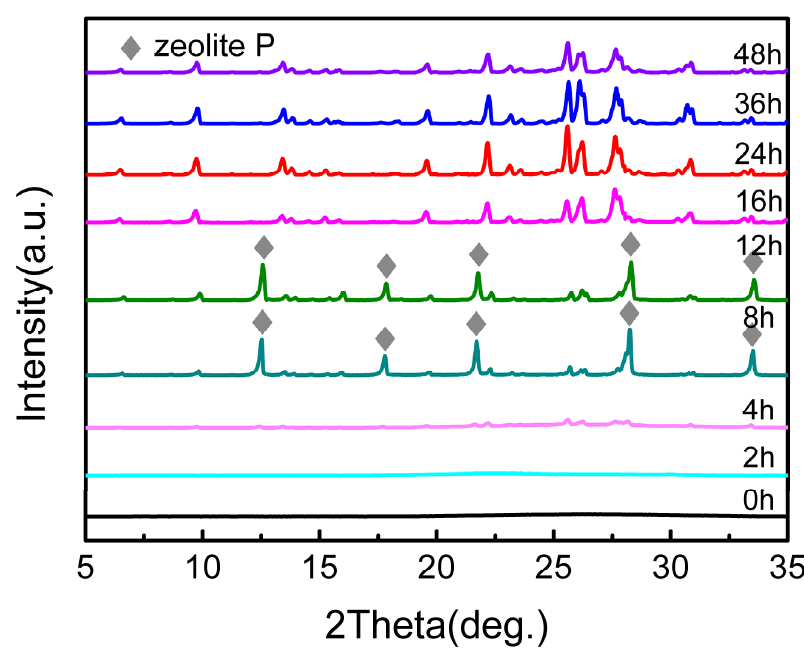
Figure 4. XRD patterns of IW–MOR samples that were crystallized for 0, 2, 4, 8, 12, 16, 24, 36, and 48 h.